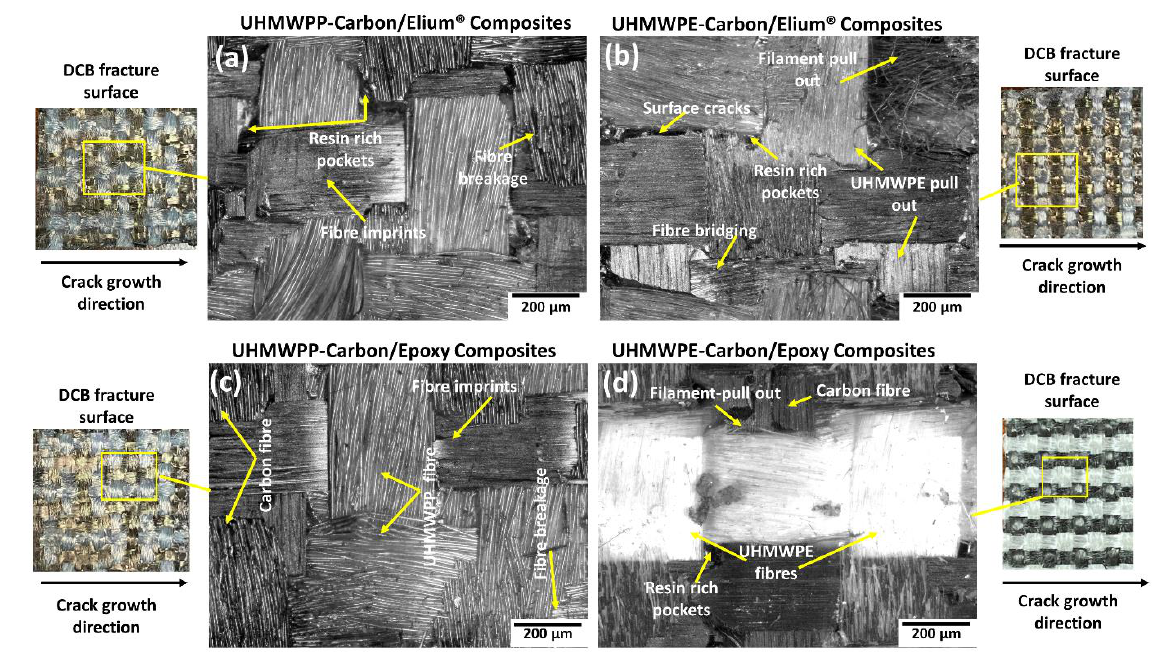
Figure 10. Micrographic images of the failed surfaces of ( a ) Carbon_UHMWPP/Elium ® ( b ) Carbon_UHMWPE/Elium ® ( c ) Carbon_UHMWPP/Epoxy and ( d ) Carbon_UHMWPE/Epoxy reinforced composite configurations under Mode I loading.